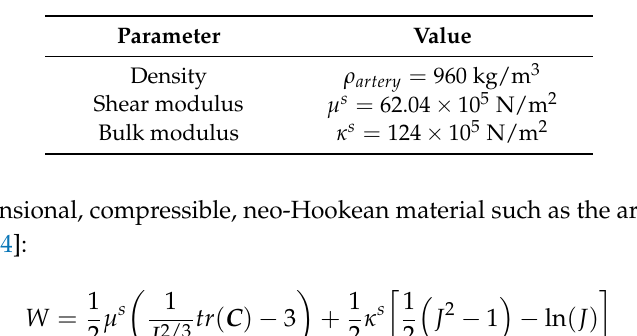
Table 1. Mechanical parameters of the